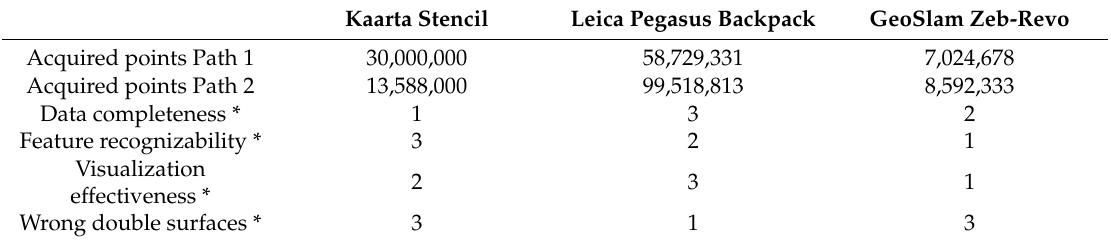
Table 3. Subjective evaluation of qualitative criteria considered in the test.